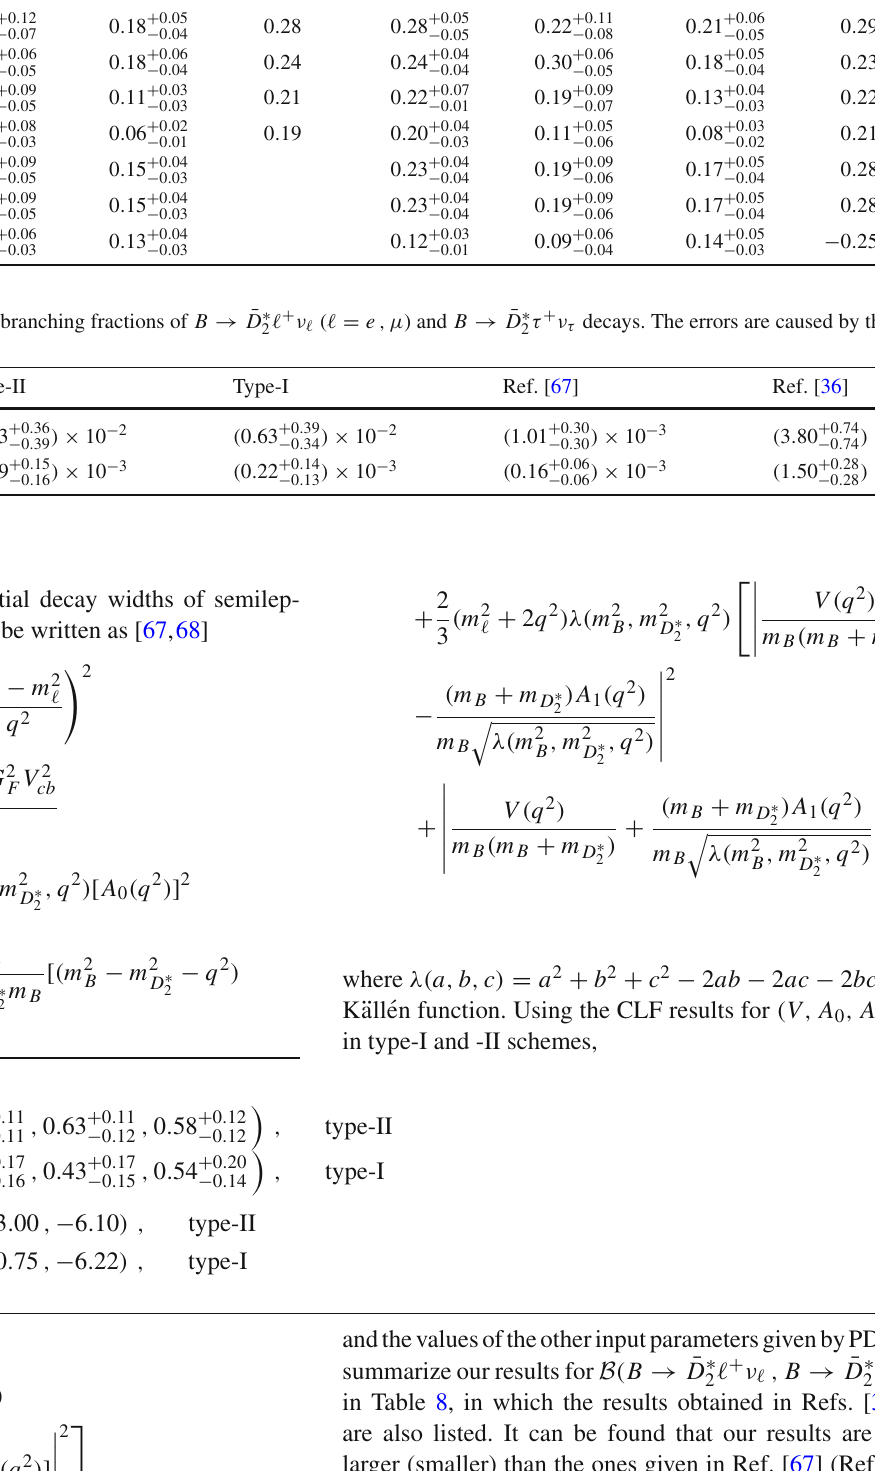
transitions at q 2 = 0 in this work, LCSR [36], PQCD [41] and 2 2